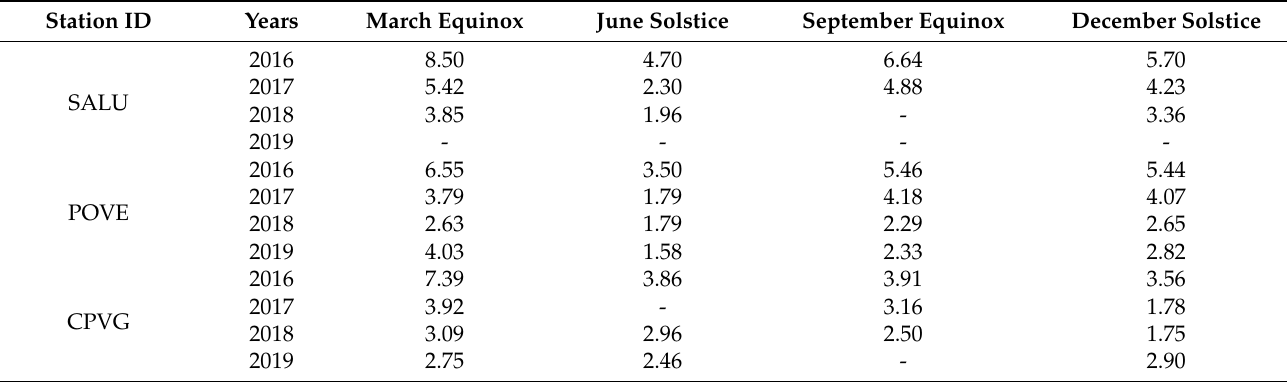
Table 2. RMSE between GPS-TEC and